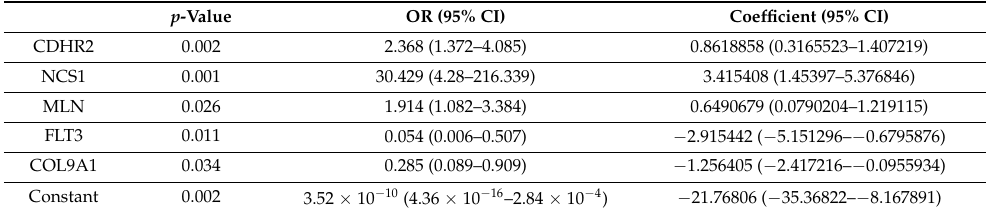
Table 7. Oncology panel: result of the stepdown procedure applied to the saturated multivariate logistic regression model.